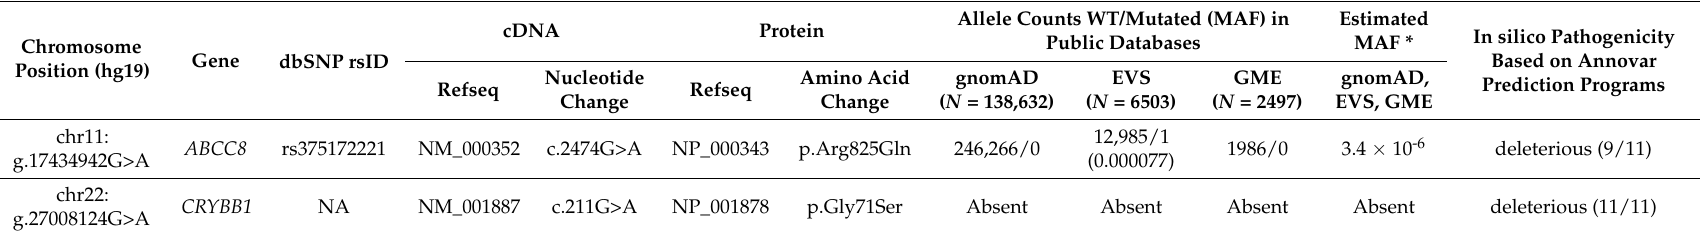
Table 1. Characteristics of the mutations identified in the ABCC8 and CRYBB1